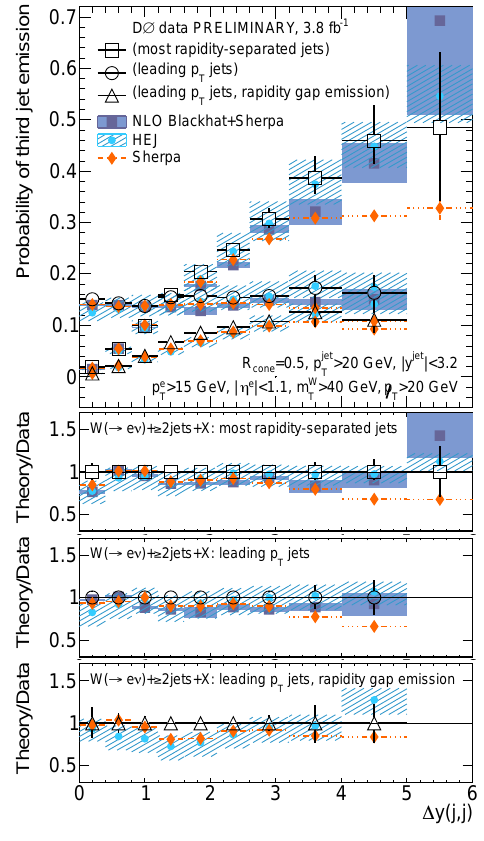
Figure 1. Measurement of the probability of emission of a third jet in inclusive W + 2-jet events as a function of the dijet rapidity separation of the two most rapidity separated jets (open squares), of the two leading p T jets (open circles), of the two leading p T jets with a requirement that the third jet be emitted into the rapidity gap defined by the two leading jets (open triangles) [4]. Comparison is made to NLO BLACKHAT + SHERPA predic- tions, HEJ all-order resummation predictions and SHERPA ma- trix element parton shower matched Monte Carlo